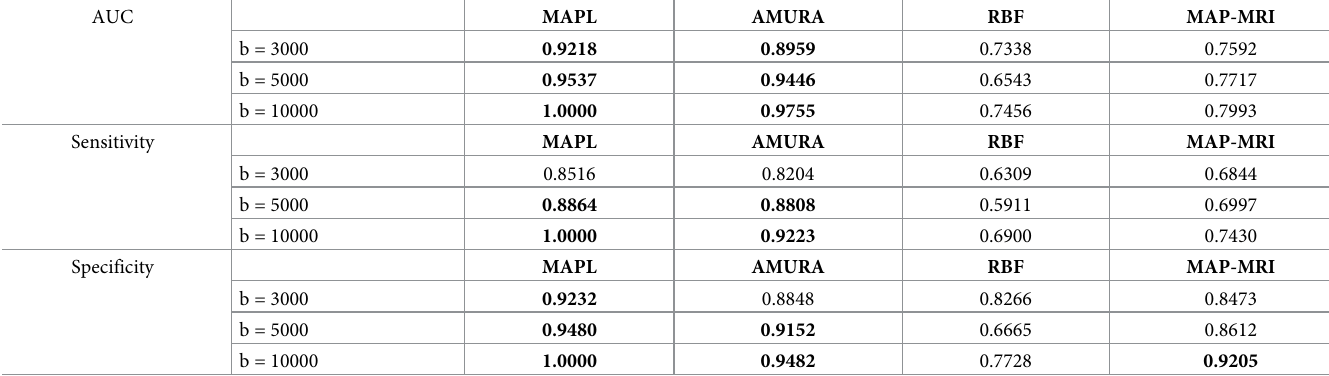
even if the number of shells increases. Finally, it is worth noticing that the apparent values obtained with AMURA at either b = 3,000s/mm 2 or b = 5,000s/mm 2 score pretty close to MAPL when the outermost shell at b = 10,000s/mm 2 is suppressed from the bronze standard. Summarizing, not only AMURA strongly correlate with measures derived from multi-shell techniques, but they seem to distinguish tissue properties as well as the other methods do. Table 6. ROC FoMs for RTAP (the closer to 1, the better). MAPL with 4 shells at a maximum b = 10,000s/mm 2 is the bronze